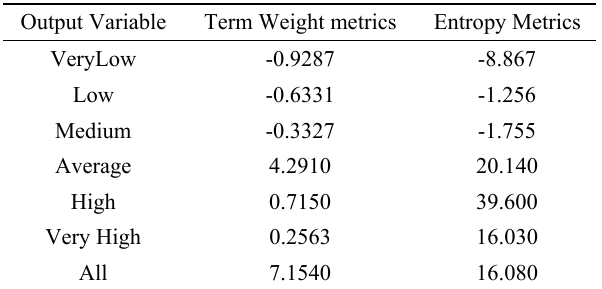
Table 15: Adaptive neural-fuzzy inference system information fusion technique output linguistic variables and the corresponding generated values using term weight and entropy identity attributes metrics values.